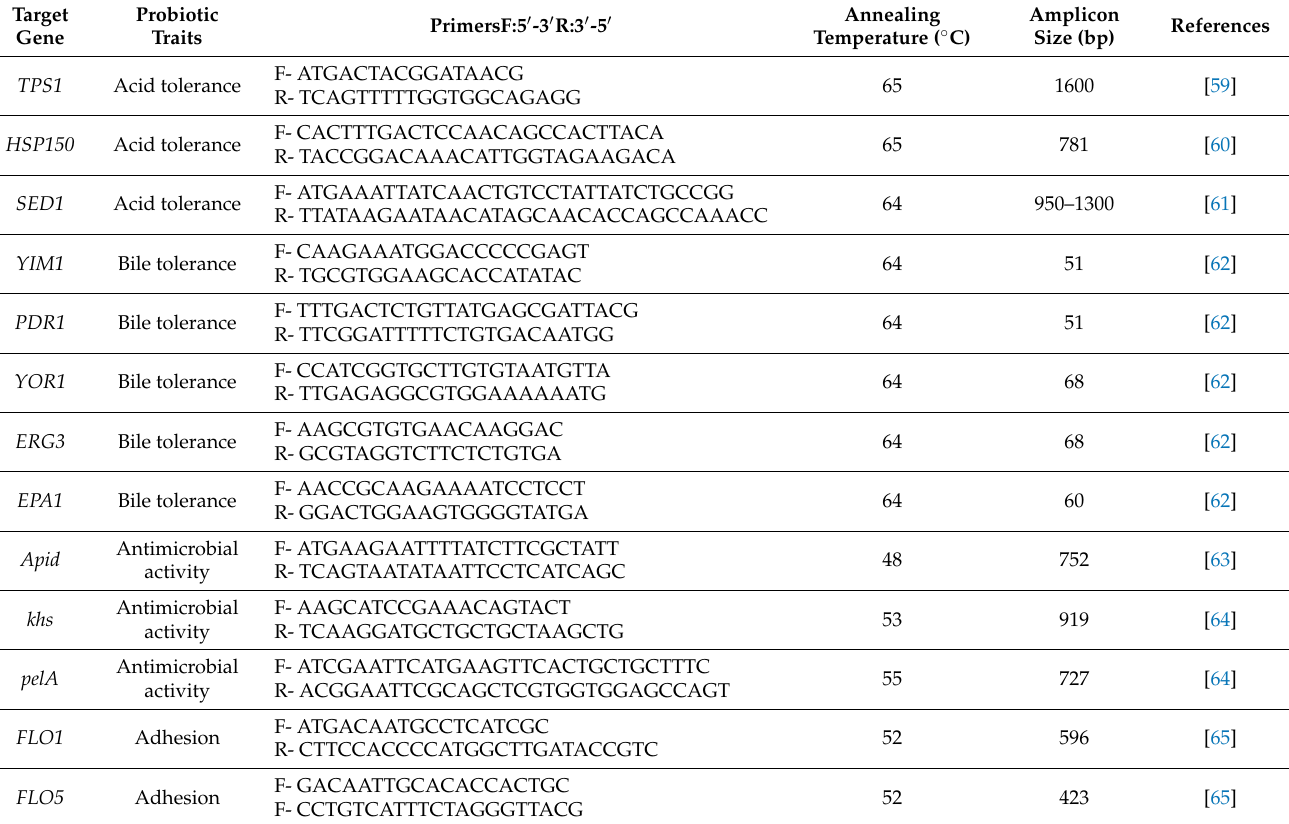
Table 1. Target genes, probiotic traits and primers used for detection of probiotic